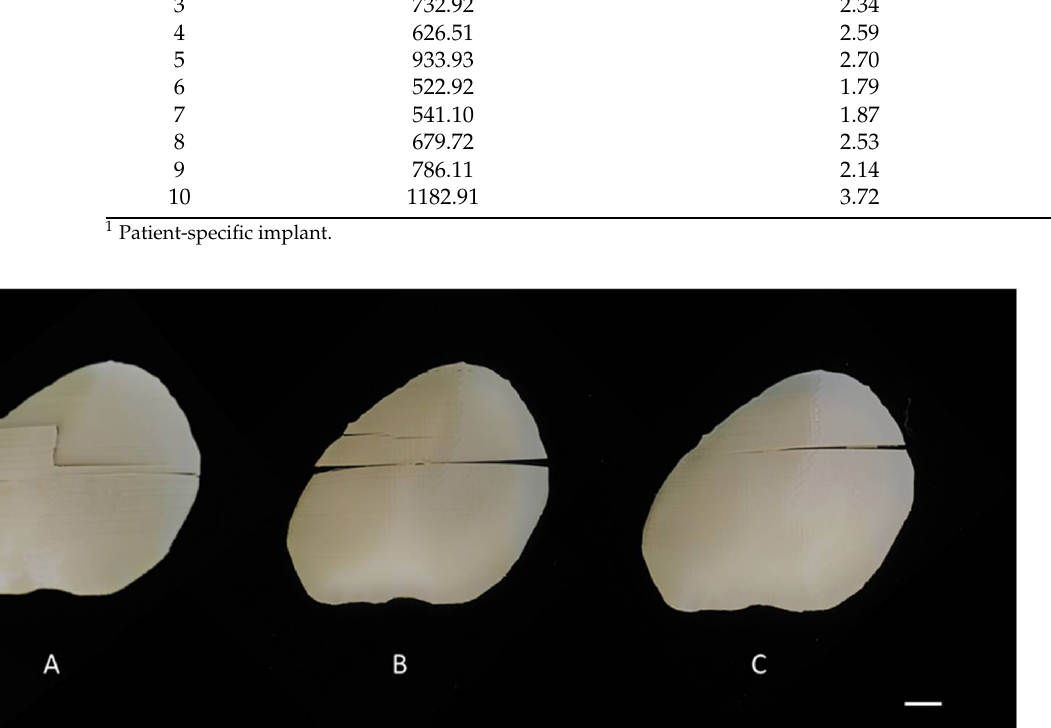
cific implants: ( A ) Class 1 (scale bar, 1 cm); ( B ) Class 2 (scale bar, 1 cm); ( C ) Class 3 (scale bar, 1 cm).